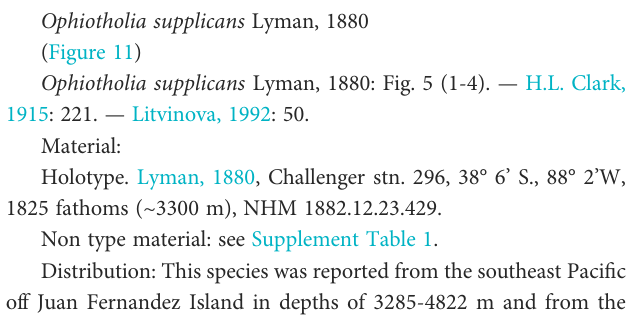
Ophiotholia supplicans Lyman, 1880: Fig. 5 (1-4). — H.L. Clark, 1915: 221. — Litvinova, 1992: 50.